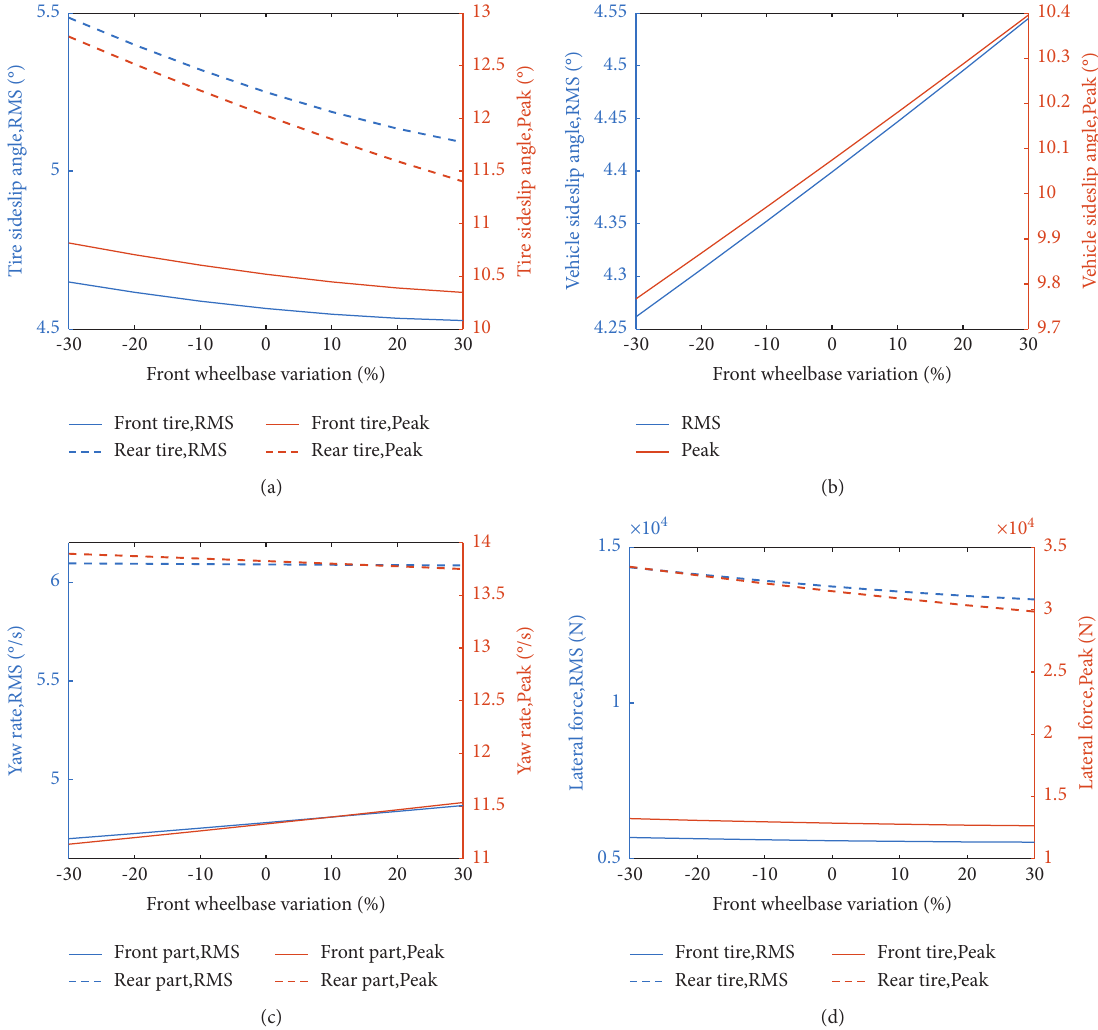
Figure 12: Vehicle performance of the front wheelbase variation. (a) RMS and peak value of tire sideslip angle. (b) RMS and peak value of vehicle sideslip angle. (c) RMS and peak vehicle yaw rate. (d) RMS and peak value of lateral force.